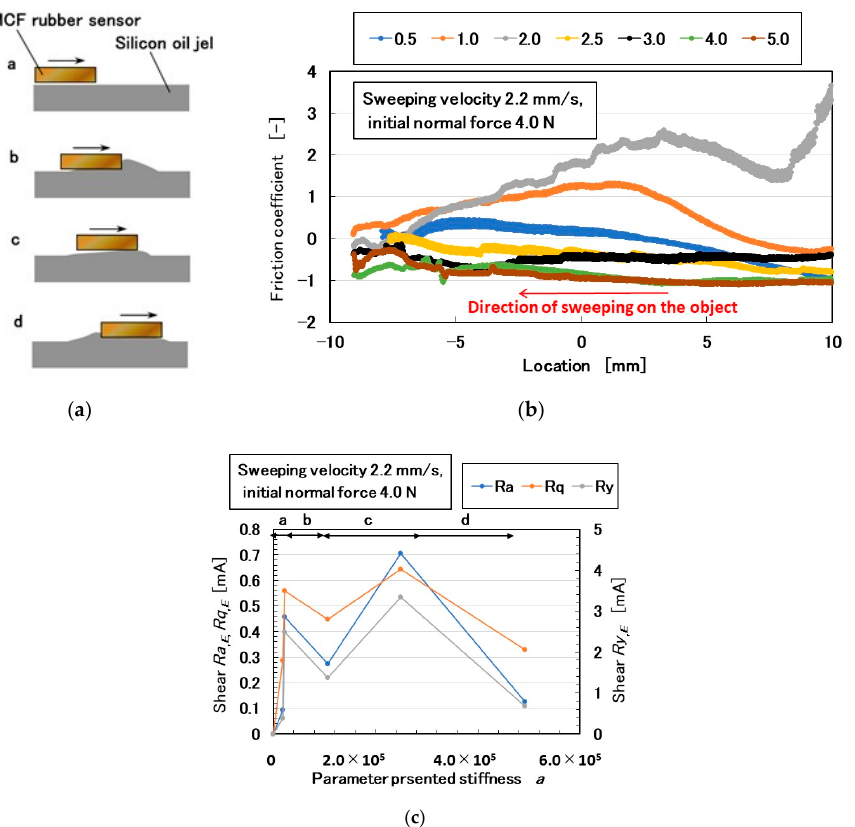
Figure 14. Model of results by touching the silicone gel with the MCF rubber sensor under shear motion: ( a ) schematic model of silicone gel deformation under shear force; ( b ) friction coefficient at various ratios of the thinner to KE1300T; ( c ) relationship of Ra ,E , Rq ,E , and Ry ,E to the parameter presented stiffness a .